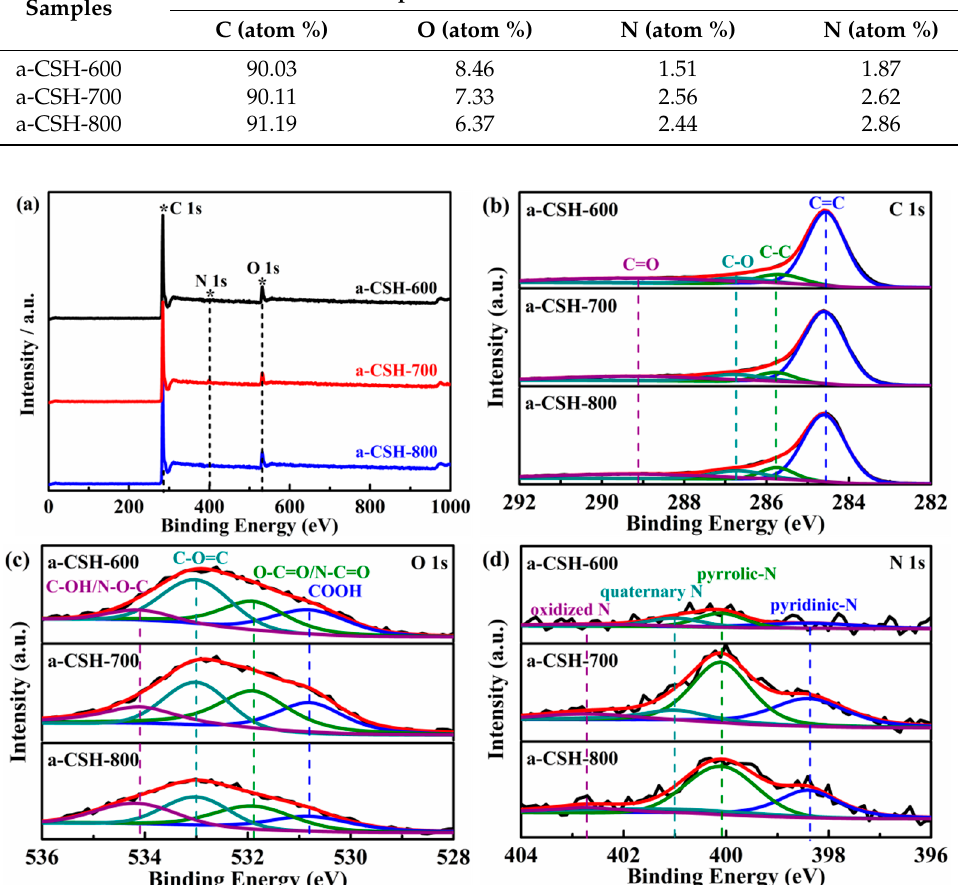
Table 2. Elemental contents of a-CSHs samples from X-ray photoelectron spectroscope (XPS) and EDS. Composition (from XPS) Samples